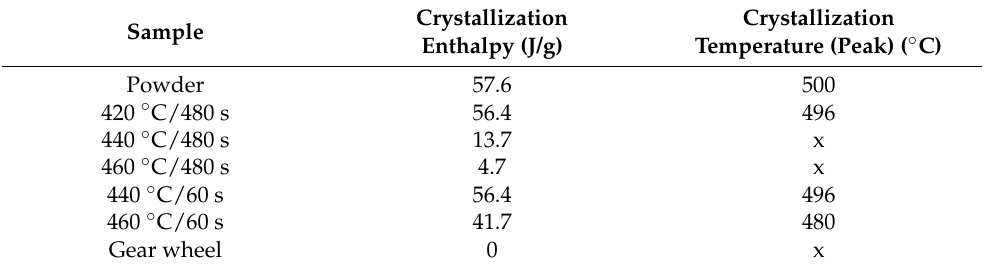
Table 1. Crystallization enthalpies and peak